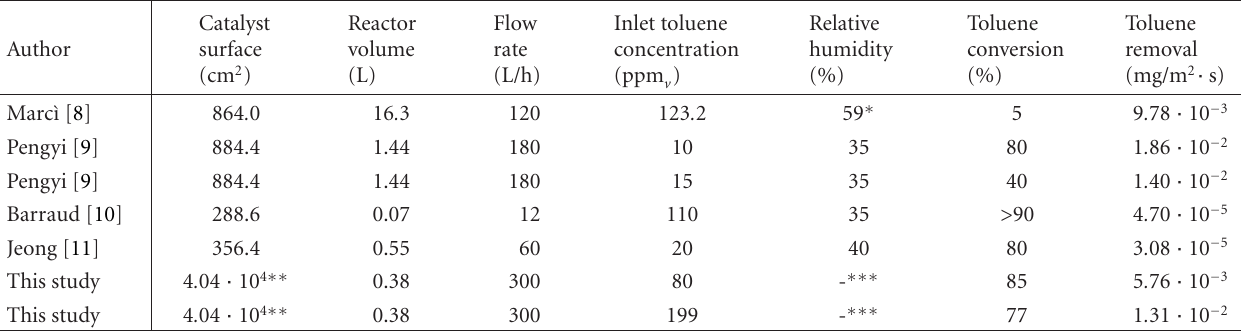
Table 1: Comparison of data in the photocatalytic removal of toluene.